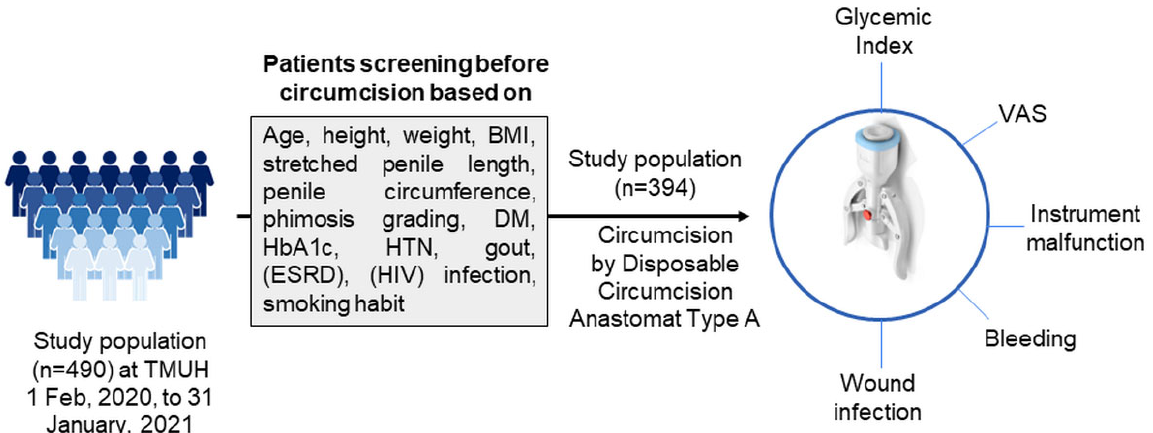
Figure 1. Schematics of the study design. Patients were screened based on their age, height, weight, BMI, stretched penile length, penile circumference, phimosis grading, DM, HbA1c, HTN, gout, (ESRD), (HIV) infection, and smoking habit. The outcomes of the study were measured in terms of glycemic index, wound infection, VAS, bleeding, and instrument malfunction. BMI: body mass index, DM: diabetes mellitus, HbA1C: glycated hemoglobin, HTN: hypertension, ESRD: end-stage renal disease, HIV: human immunodeficiency virus, VAS: visual analog scale.